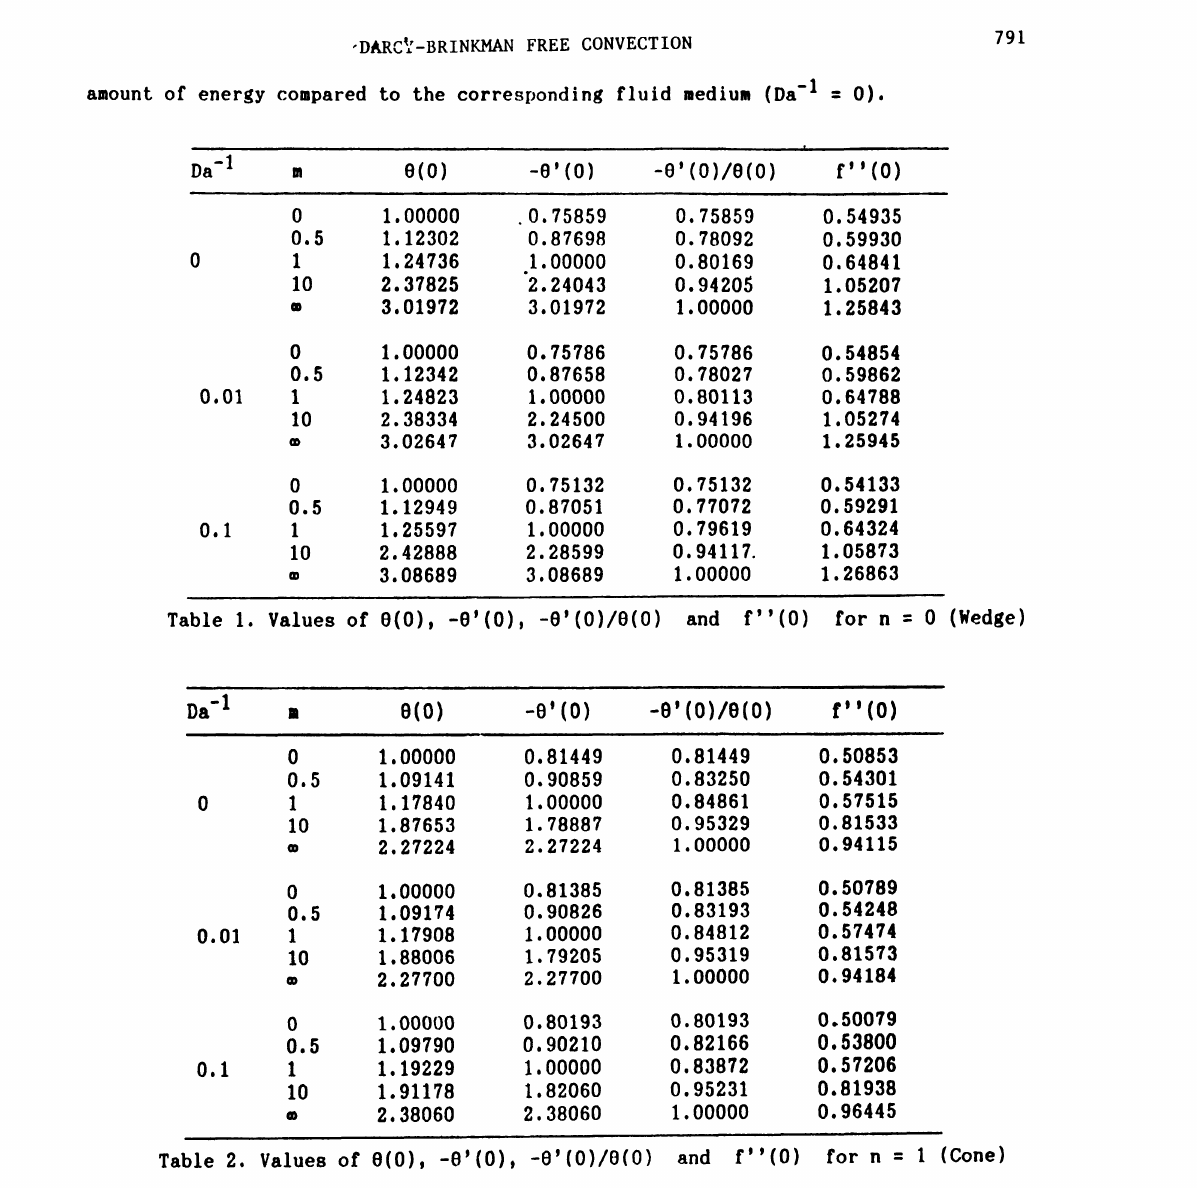
Table 2. Values of e(o), -e’(o), -e’{0)/0(0) and f"{0} for n